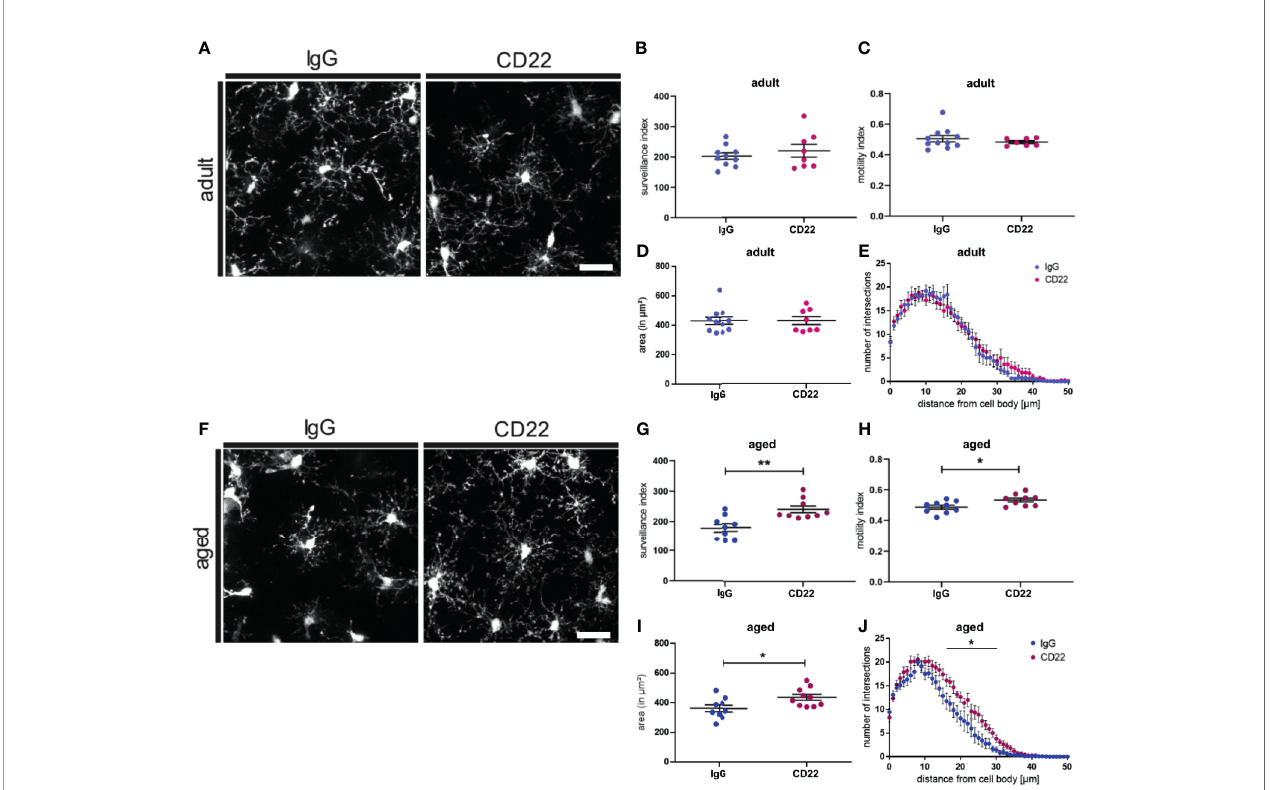
FIGURE 4 | Blockage of CD22 restores age-associated de fi cits in surveillance and rami fi cation. (A) Representative two-photon images of microglia from acute slices prepared from adult (7-8 months) mice, which were either treated with a CD22 or an IgG isotype control antibody. Respective analysis of the (B) surveillance index and (C) motility index as well as the (D) area and the (E) sholl analysis re fl ecting the microglial rami fi cation. (F) Two-photon images of microglia from aged (13-16 months) mice demonstrating the effect of treatment with CD22-blocking antibody. Quanti fi cation of the (G) surveillance index (H) motility index, (I) area and (J) sholl analysis comparing the antibody treatments. For (B – E) and (G – J) n=7-11 cells from n=7 mice each, mean ± SEM, unpaired nonparametric t-test (Mann-Whitney), *p<0.05, **p<0.01. Scale bar: 20